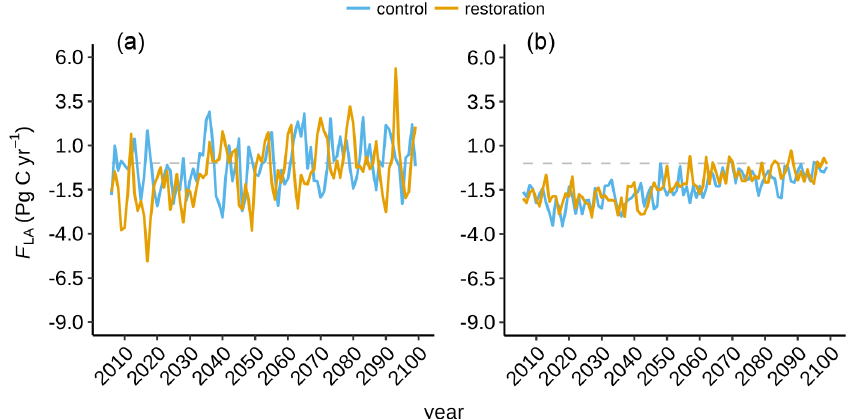
Figure A4. Tropical (a) and extratropical (b) land–atmosphere flux ( F LA ) in the restoration (yellow) and control (blue) simulations.